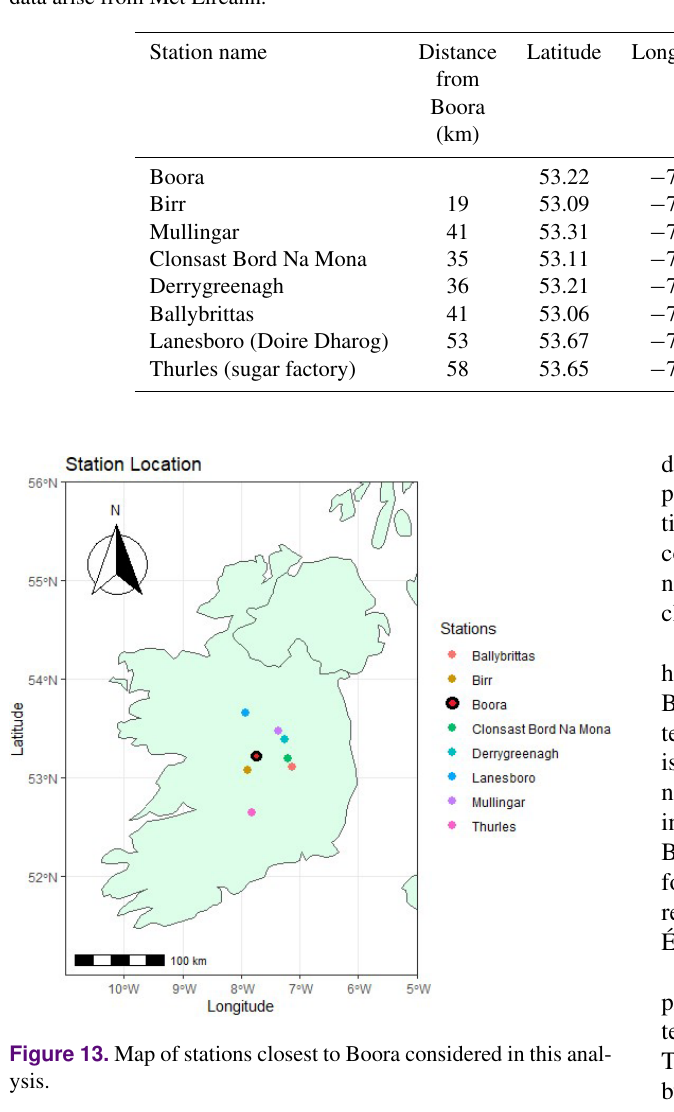
Table 3. Comparison between Boora, Offaly, maximum temperature on 29 June 1976 and neighbouring stations within a 60km radius. All data arise from Met Éireann.